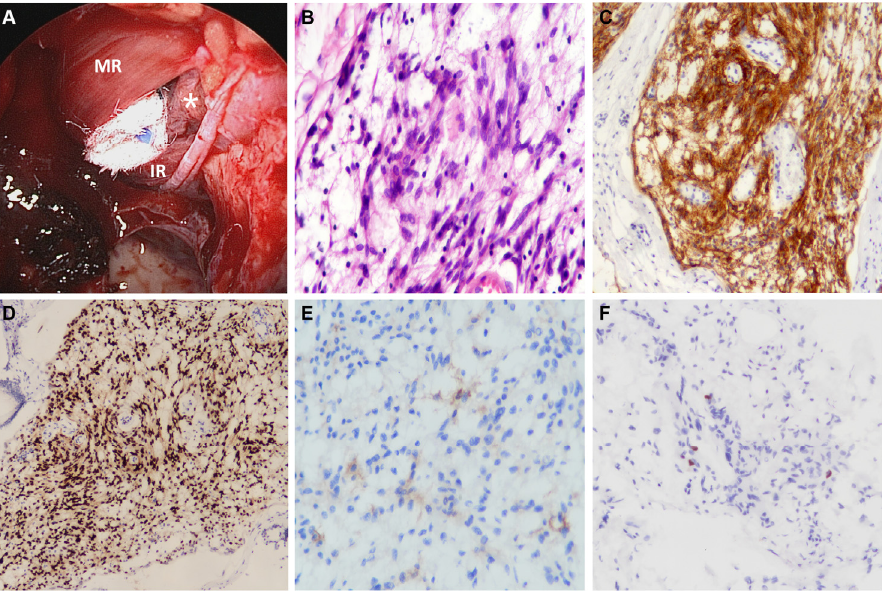
Figure 2. The intraoperative pictures and the histopathological findings. ( A ) The medial rectus muscle (MR) and inferior rectus muscle (IR) were clearly exposed after removing the lamina papyracea and the periorbita. The 0° endoscope revealed the tumoral tissues (asterisk) through the in- traconal surgical corridor created between the two muscles. ( B ) The hematoxylin-eosin staining demonstrated syncytial meningothelial cells with eosinophilic cytoplasm arranged in characteris-